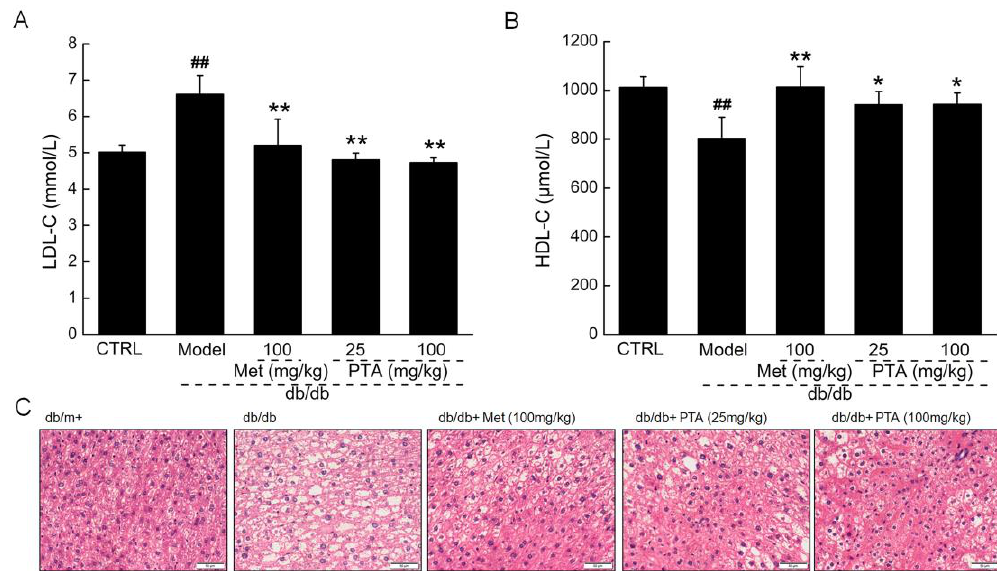
Figure 3. PTA regulates lipid metabolism in db / db mice. PTA reduced the levels of ( A ) low density lipid cholesterol (LDL-C and enhanced the levels of ( B ) high density lipid cholesterol (HDL-C in sera of db / db mice after eight-week administration. Data are expressed as means ± SD (n = 12). ## p < 0.01 vs. db / m + mice, * p < 0.05 and ** p < 0.01 vs. non-treated db / db mice. ( C ) Histopathological analysis of liver via H and E staining (scale bar: 50 µ m) (magnification: 200 × ) (n = 6).